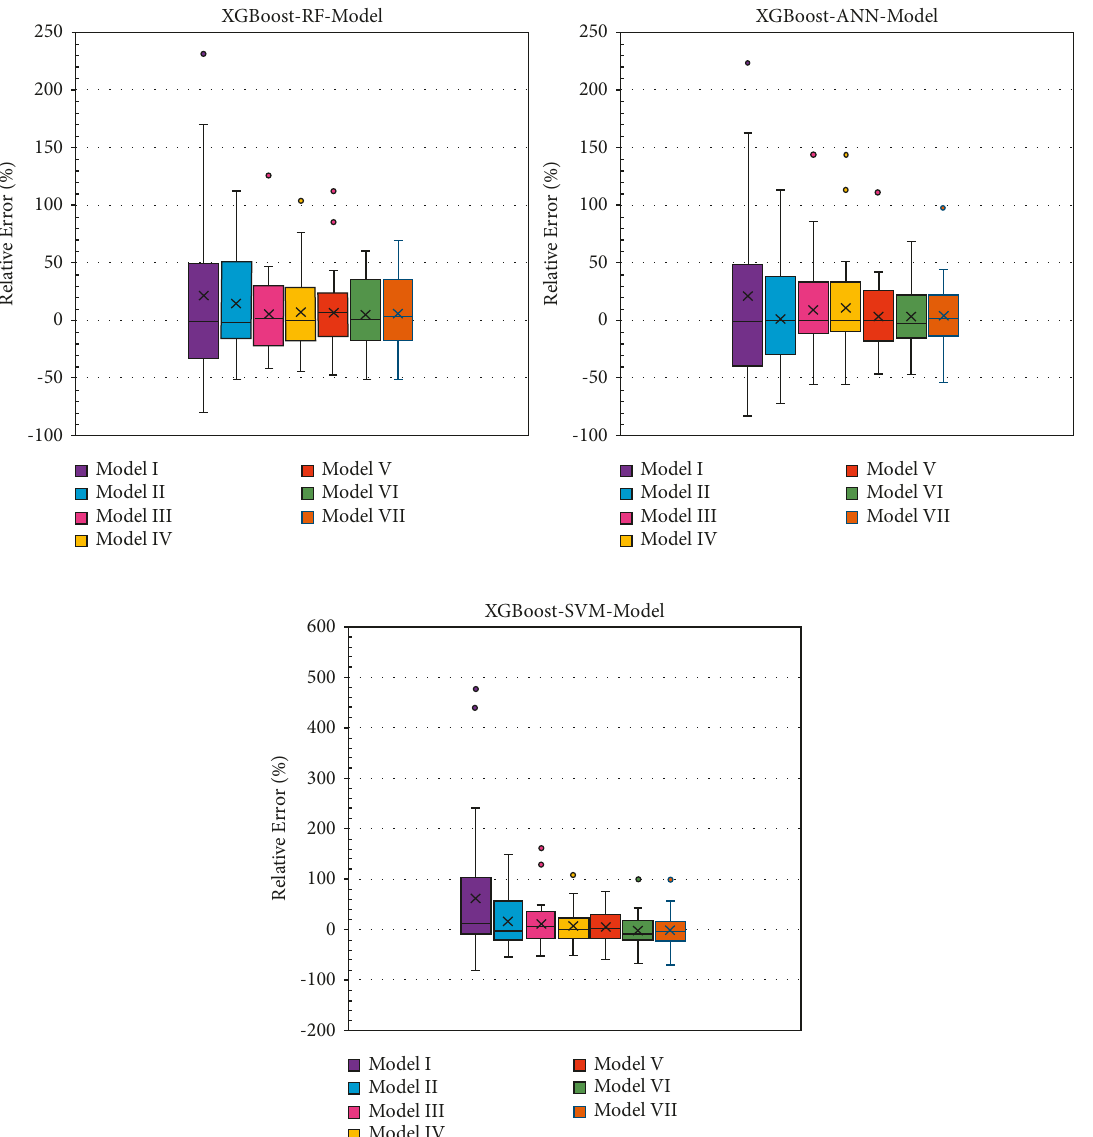
Figure 9: Box plot presentation of the developed AI models for the testing